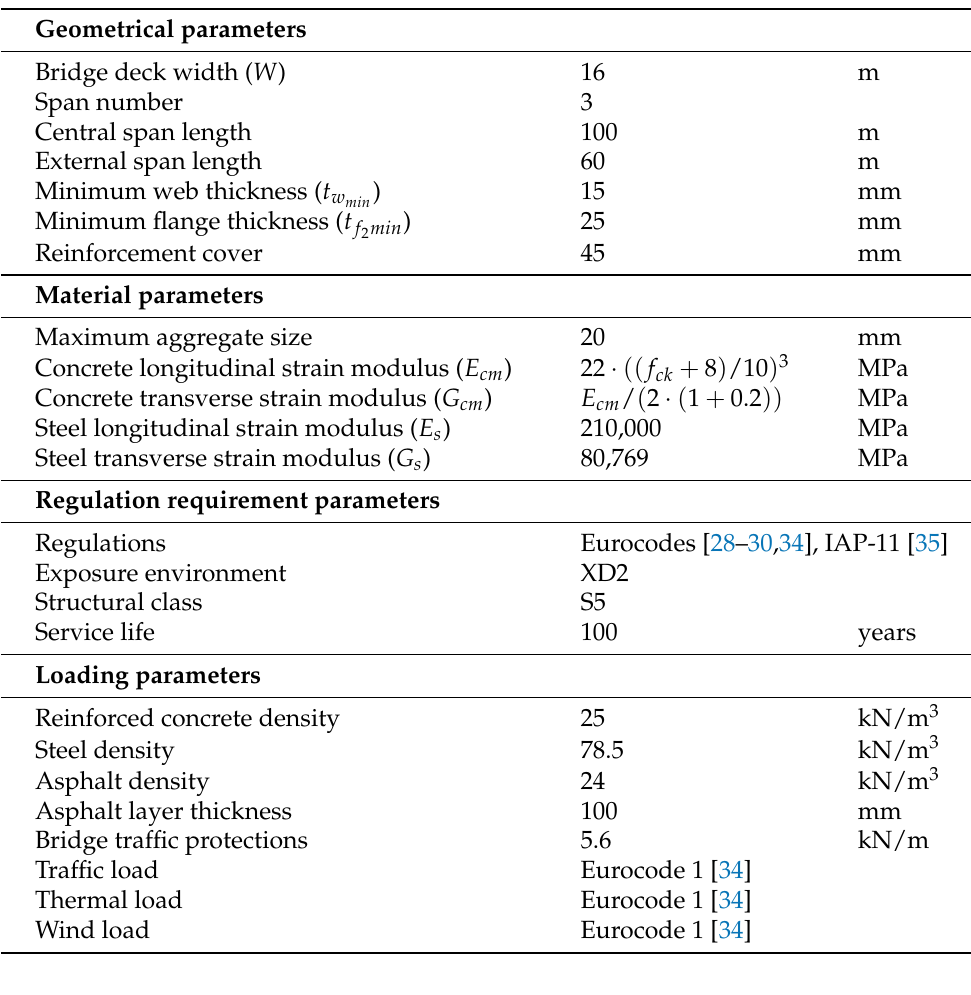
Table 3 defines the parameters used for the bridge optimization problem. These parameters consider the Eurocode structural checks [28–30], the bridge spans length that corresponds to 60–100–60 m as can be seen in Figure 2, the deck width ( B ) of 16 m, and guides [32,33]. Table 3. Parameters of the SCCB optimization problem.